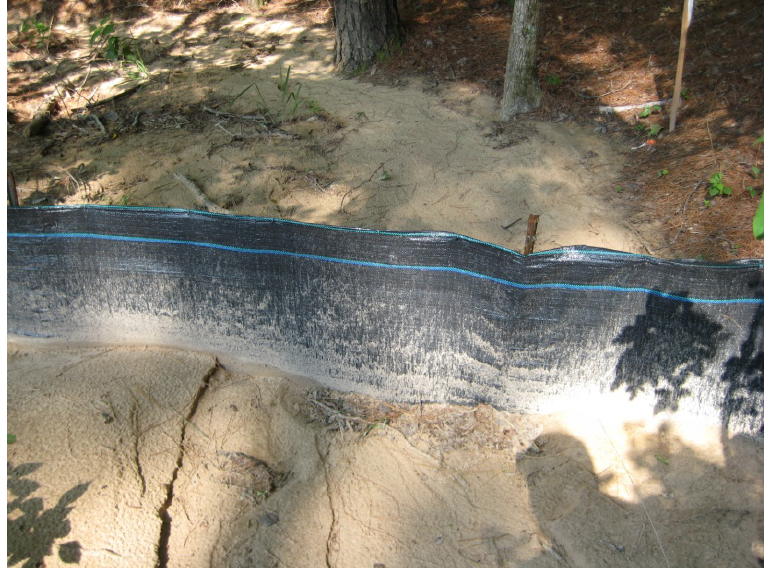
Figure 8. Silt fence installed below the natural gas well pad at F1 illustrating the ineffectiveness of this sediment control technique due to poor installation and large sediment volumes eroded at the Alto Experimental Watersheds in Texas,